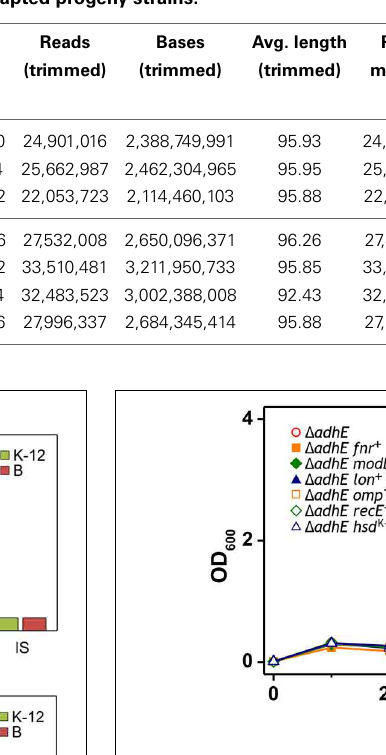
FIGURE 5 | Anaerobic growth of BL21(DE3) (cid:2) adhE cells supplemented with authentic fnr, modE, lon, ompT, recE , and hsd genes of the K-12